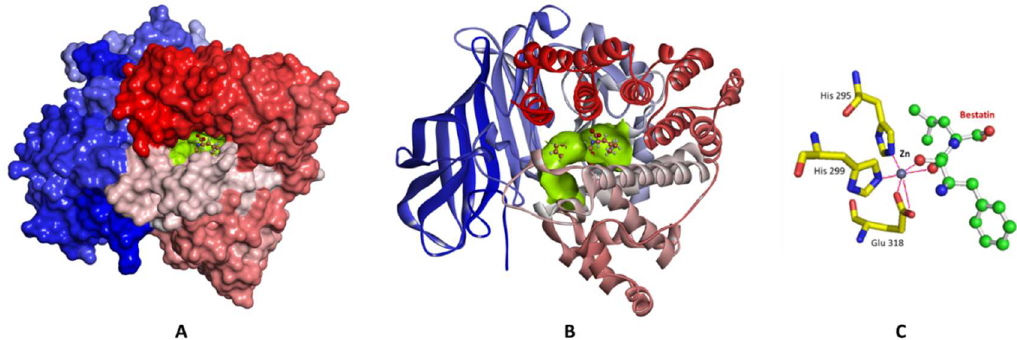
Figure 2. The crystal structure of LTA4H-Bestatin complex (PDB code 1HS6). ( A ) Surface representation of the enzyme with the active site colored green, and the complexed bestatin in balls and sticks. ( B ) Cartoon representation of the enzyme colored N-to-C terminal, blue-to-red respectively. The active site is shown as a green surface, and bestatin in balls and sticks. ( C ) A close-up view of the active site showing the amino acid residues (yellow carbon skeleton) involved in coordinating the Zn ion (gray sphere) and bestatin (green carbon skeleton); coordination interactions with Zn are shown as red lines.